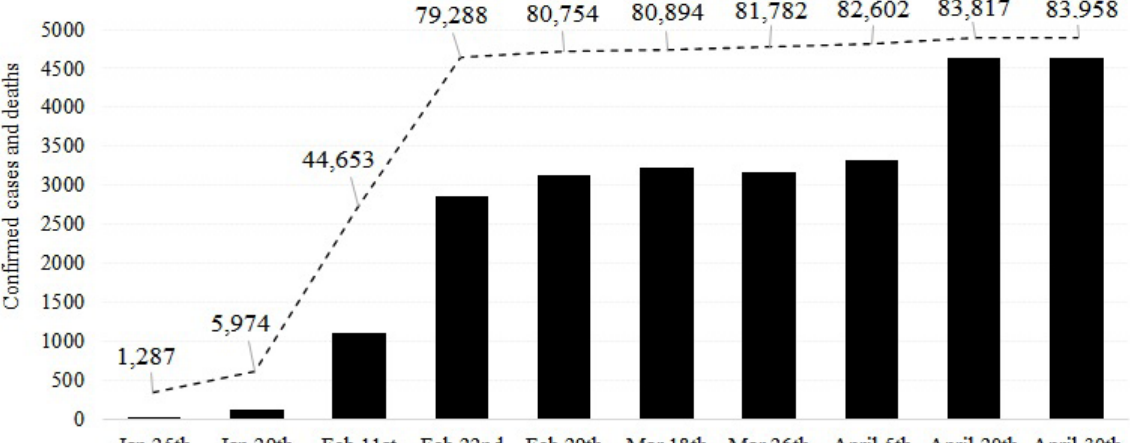
Figure 1. Briefing of daily infographics disclosed by China in the National Health Commission of the people’s Republic of China, the last date available was in April 30 th (http://en.nhc.gov.cn/index.html). Black vertical bars represent the total deaths by date, and the dotted line represents the number of cases by time.